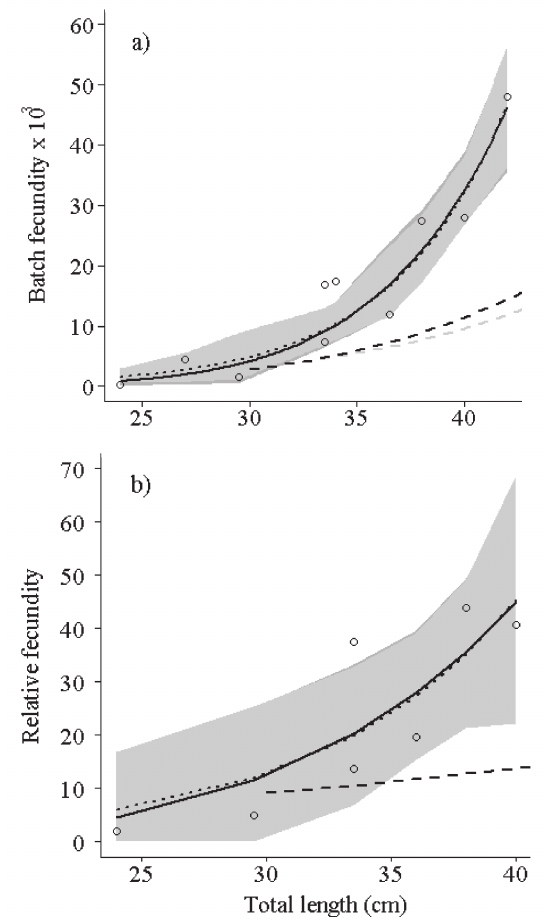
Fig. 7. Power (black lines) and exponential (dotted lines) relationships between (a) batch fecundity and total length, and (b) relative fecundity and total length in Pinguipes brasilianus . Shaded areas (grey and light grey, respectively) represent 95% confidence regions. Raw data are showed as open circles. Dashed lines show the same functions for P. chilensis , based on the function parameters reported by González Kother